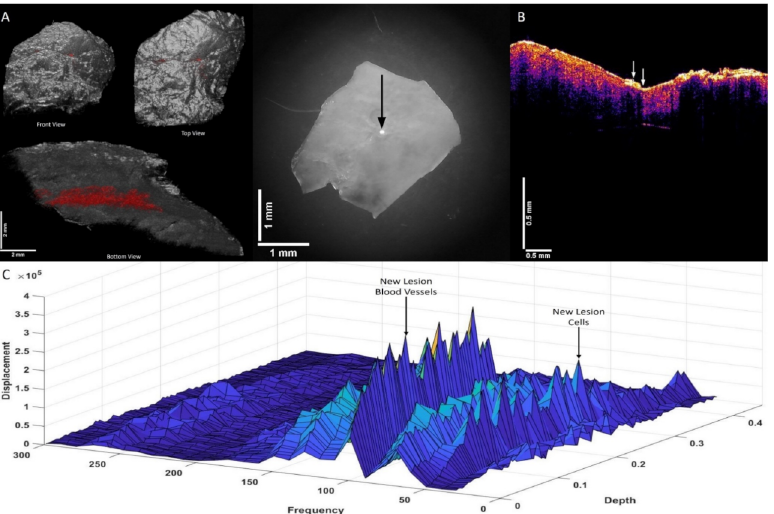
Figure 3. Two-dimensional color-coded OCT images ( A ) of an actinic keratosis (AK) illustrating the location of new dermal cells and new blood vessels in red (left) and a camera image of the lesion (right). The arrow shows the location where the VOCT data were collected. ( B ) shows an OCT image of the cross-section of the point where the data were collected. Note the lesion is seen as a black spot in the area below the arrows. ( C ) shows a 3D plot of weighted displacement versus frequency and depth showing the location of new lesions cells (80 Hz), papillary collagen (100 Hz), and new lesion blood vessels (130 Hz). Note that the peaks at 80 Hz and 130 Hz are not seen in normal skin. The organization of the new cells and new lesion blood vessels are seen in an almost linear fashion (see A) in